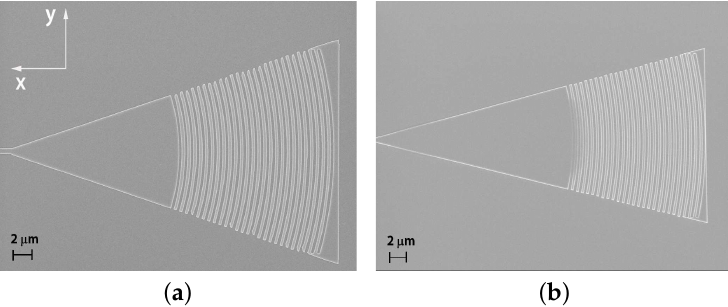
Figure 9. Top down SEM image fabricated of focusing gratings for ( a ) transverse electric (TE) ( b ) transverse magnetic (TM) fundamental mode coupling.